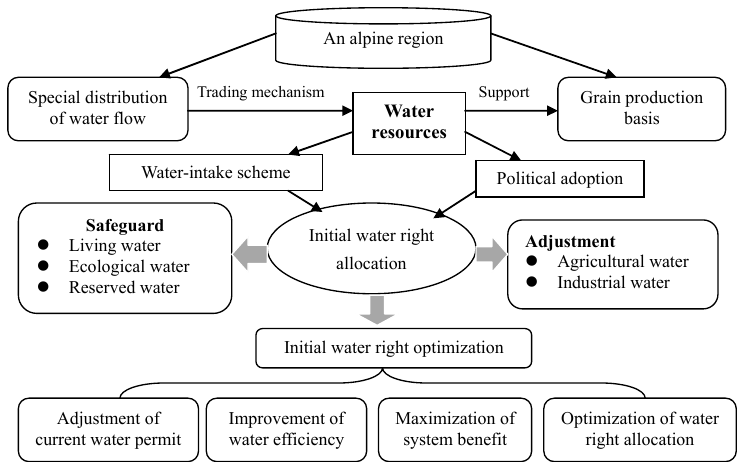
Figure 2. Framework of an initial water-rights allocation (IWRA) model in an alpine region.